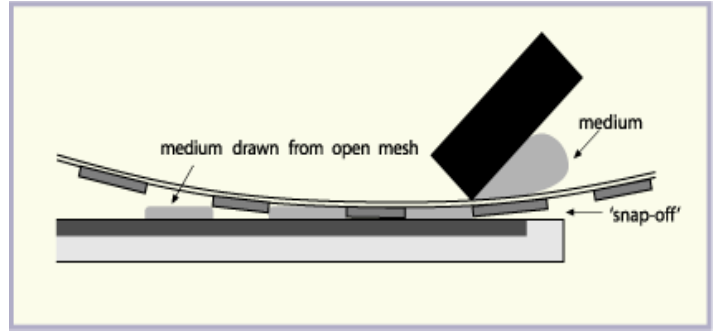
Figure 2. Mechanism of screen printing process .